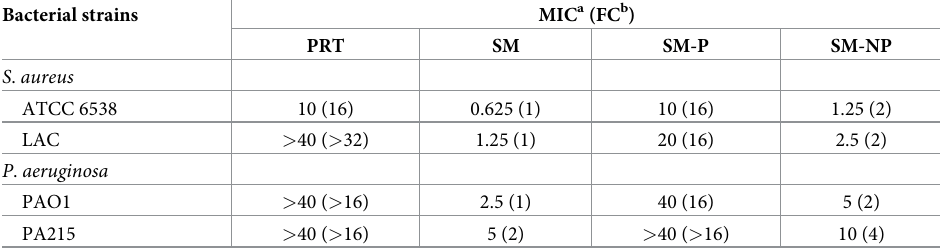
MIC was determined using a broth microdilution method as described by the Clinical and Laboratory Standards Institute. Reported values represent the median of at least 3 biological replicates. a MIC values indicate the concentration of ES-GBBr formulation fraction in % (v/v) b FC values indicate the fold change in the MIC relative to that of crude